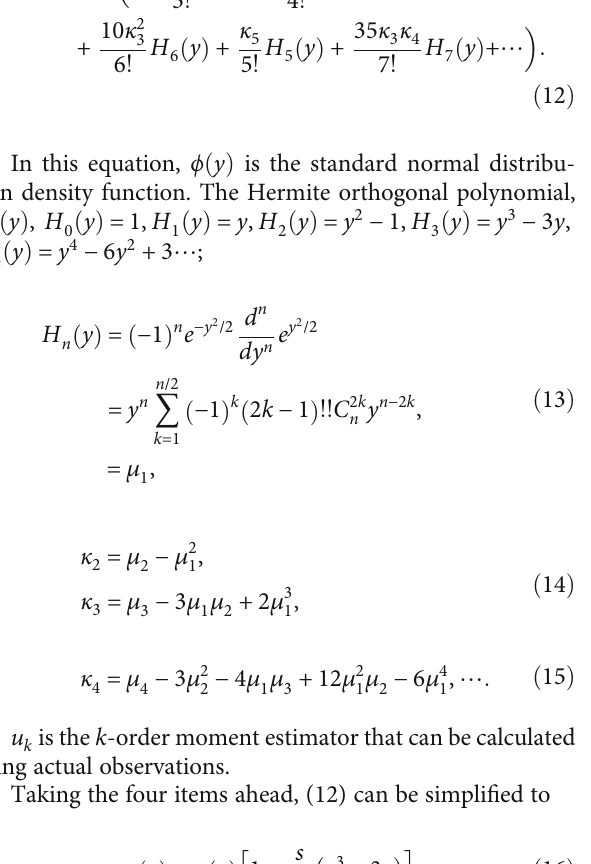
in Figure 2, the Edgeworth series curve approximation (blue line) for the density function of the on-ramps from Wuzhong Road to Caobao Road is compared with their respective histograms. During rush hour, the saturation fl ow is close to or already at maximum, and the travel time fl uctu- ation range is large; compared to normal distribution, there is a certain degree of deviation marked by s 1 and s 2 . The peak values are at s 1 = 1 : 07 and s 2 = 1 : 93 for morning travel times. The evening rush hour curve deviates to the